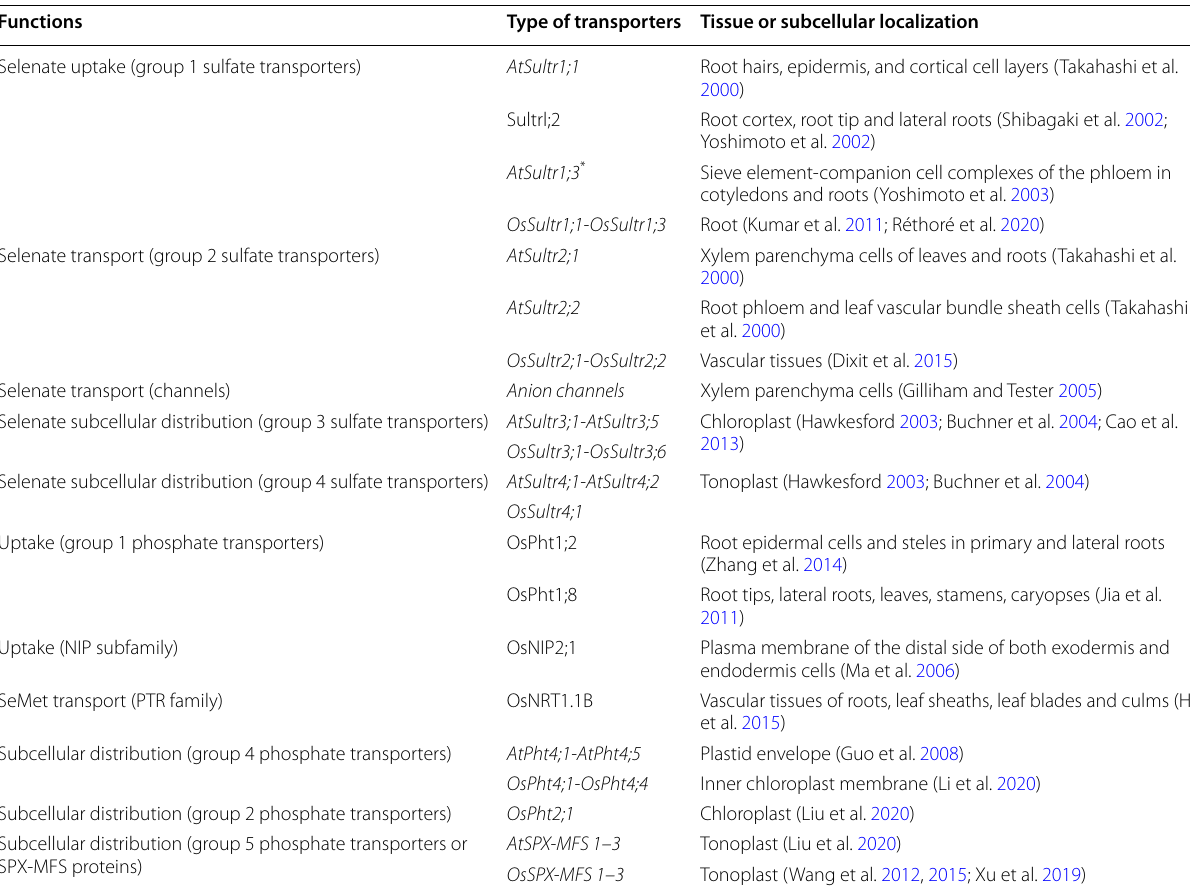
Table 1 Identified and potential transporters and channels for Se uptake, transport, and subcellular distribution